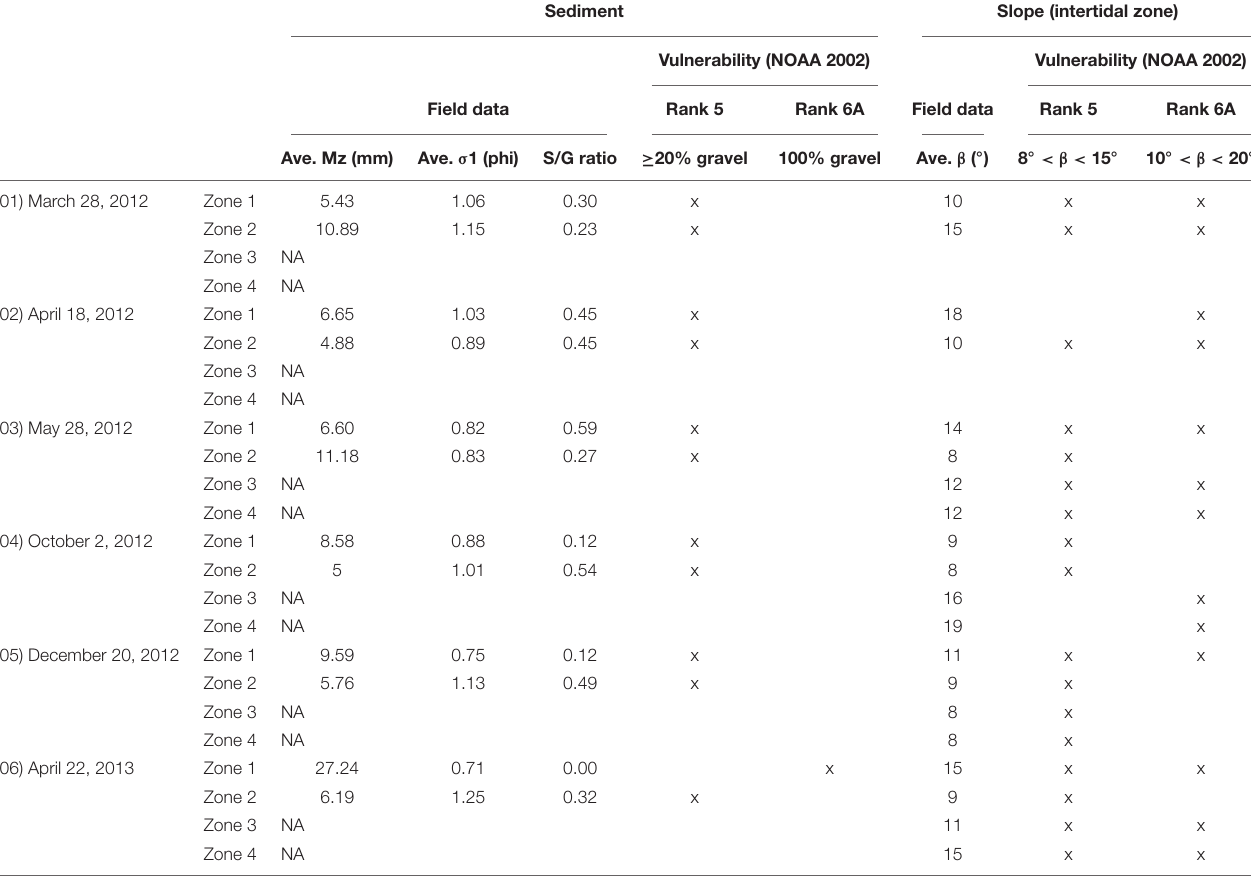
TABLE 3 | The National Oceanic and Atmospheric Administration [NOAA] (2002) classification for Portonovo according to previous sediment and slope datasets. Sediment